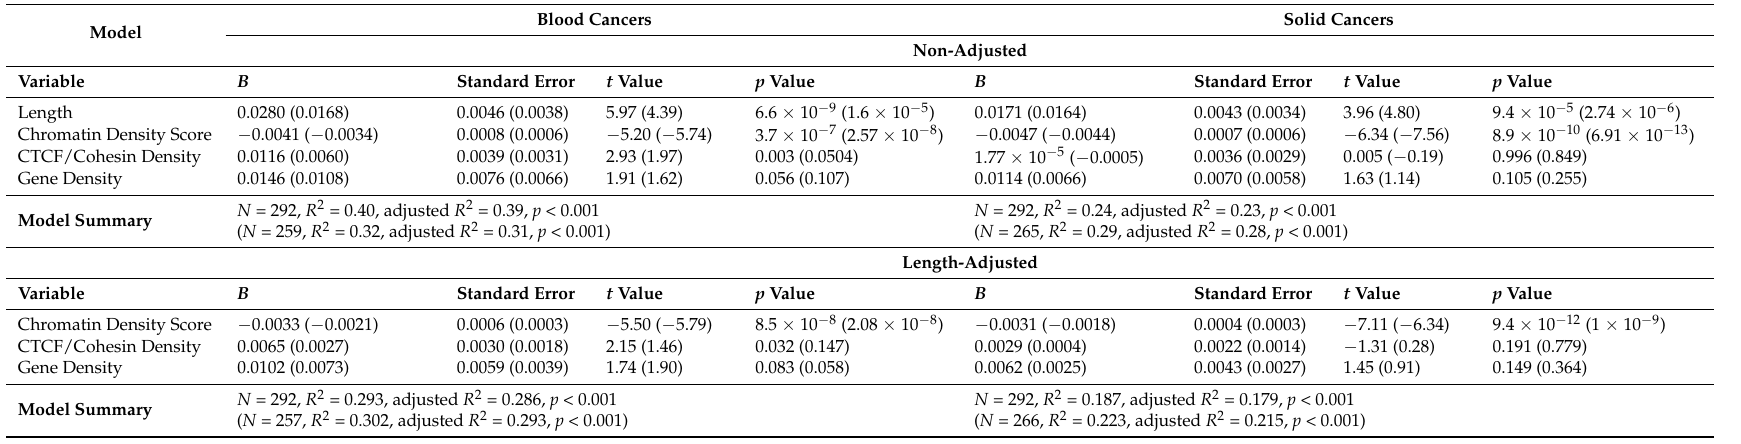
Table 1. Multiple regression analysis for translocation breakpoints in human